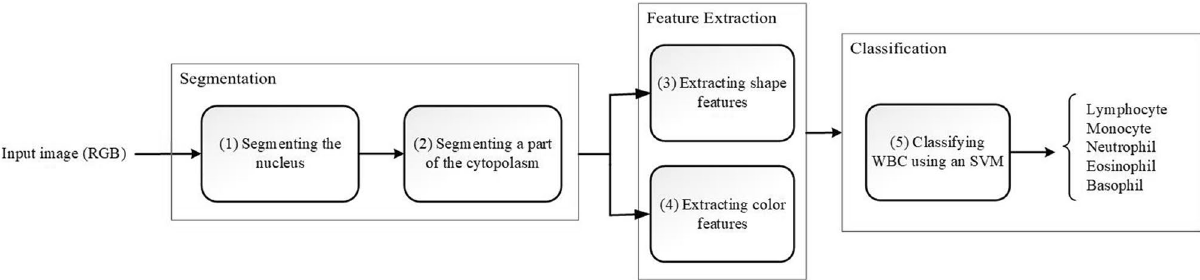
Figure 1. The block diagram of the proposed method.